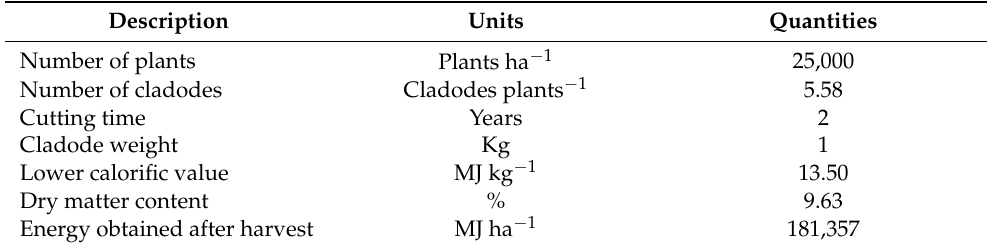
Table 10. Characterization of cactus biomass energy production in the Brazilian Northeast